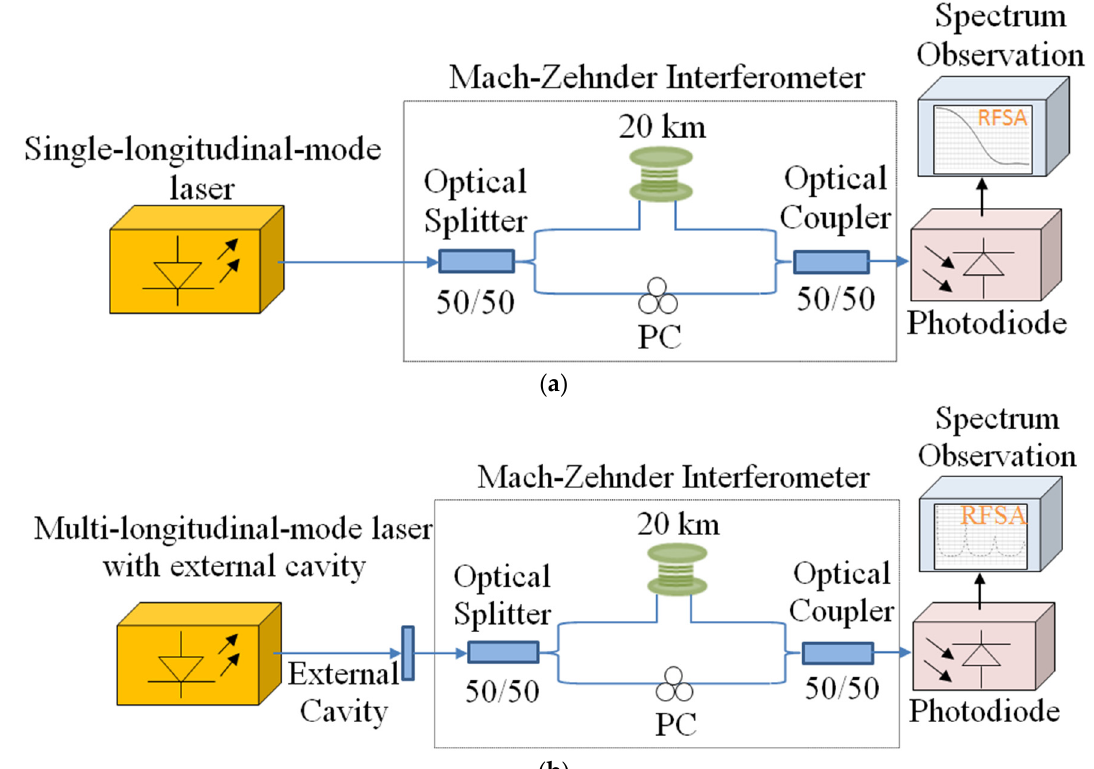
Figure 3. Schematic of delayed self-homodyne technique for measuring linewidth of ( a ) single-longitudinal-mode laser and ( b ) multilongitudinal-mode lasers with an external cavity.